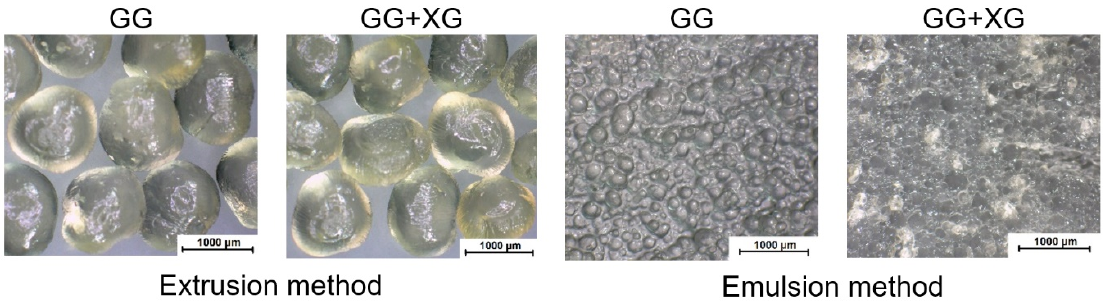
Figure 1. Microscope images of swollen microspheres prepared from gellan gum (GG) and gellan gum with xanthan gum (XG) by extrusion and emulsion method. Scale bar = 1000 µ m. Table 2. Diameters of microspheres obtained by extrusion and emulsion methods.